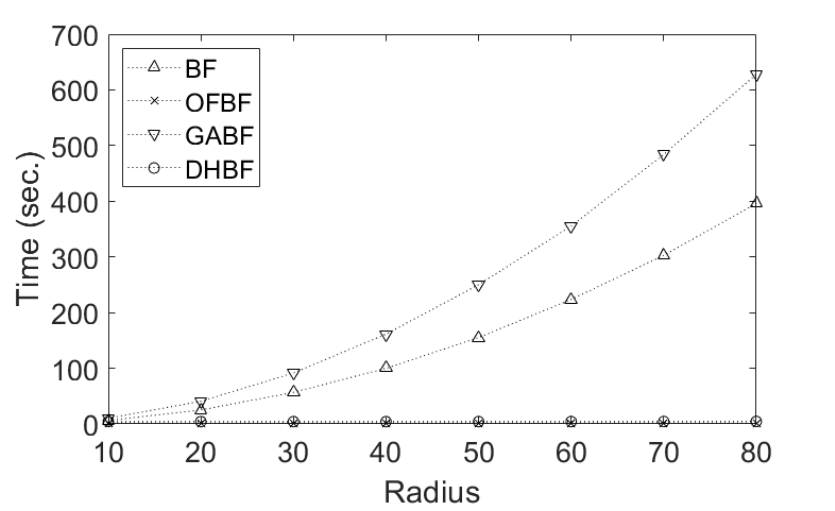
Figure 12. Runtime comparisons of the compared BF